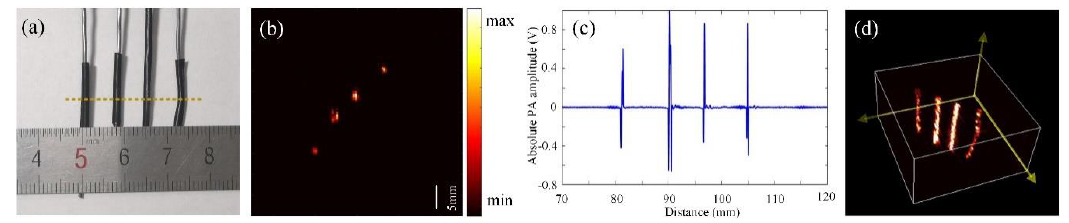
Figure 8. ( a ) Phantom of confirmatory experiment on scope, ( b ) reconstructed PA image of target, ( c ) one of an A-line of (b), and ( d ) 3D photoacoustic image.